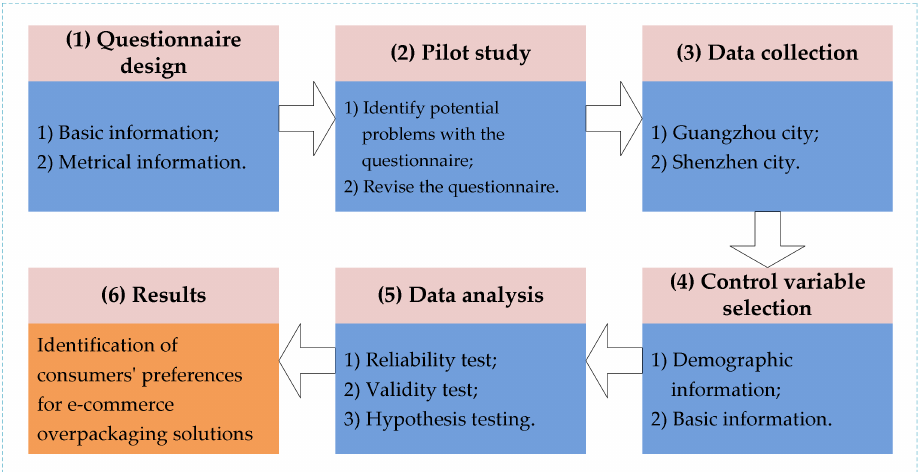
Figure 2. Research